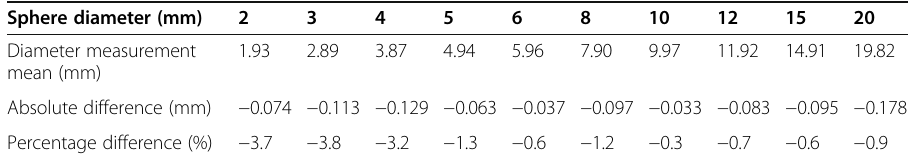
Table 3 Sphere diameter measurements Sphere diameter